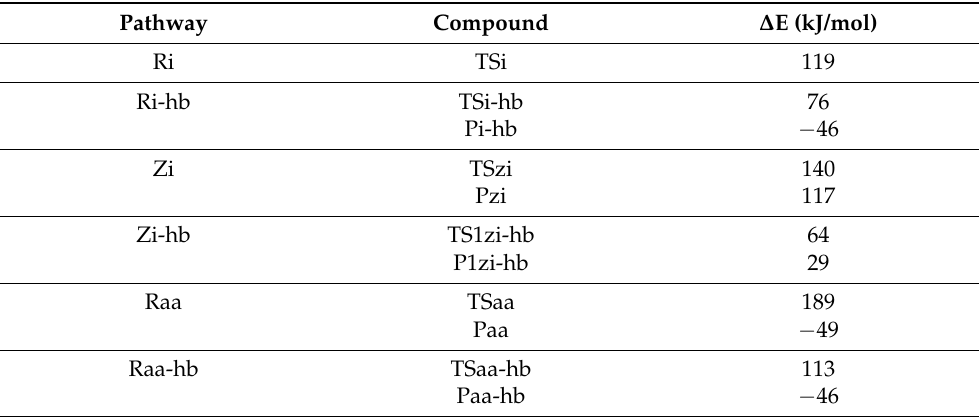
Table 3. Computed classical energy barriers for transition states and products via different reaction pathways at 0 K. Pathway